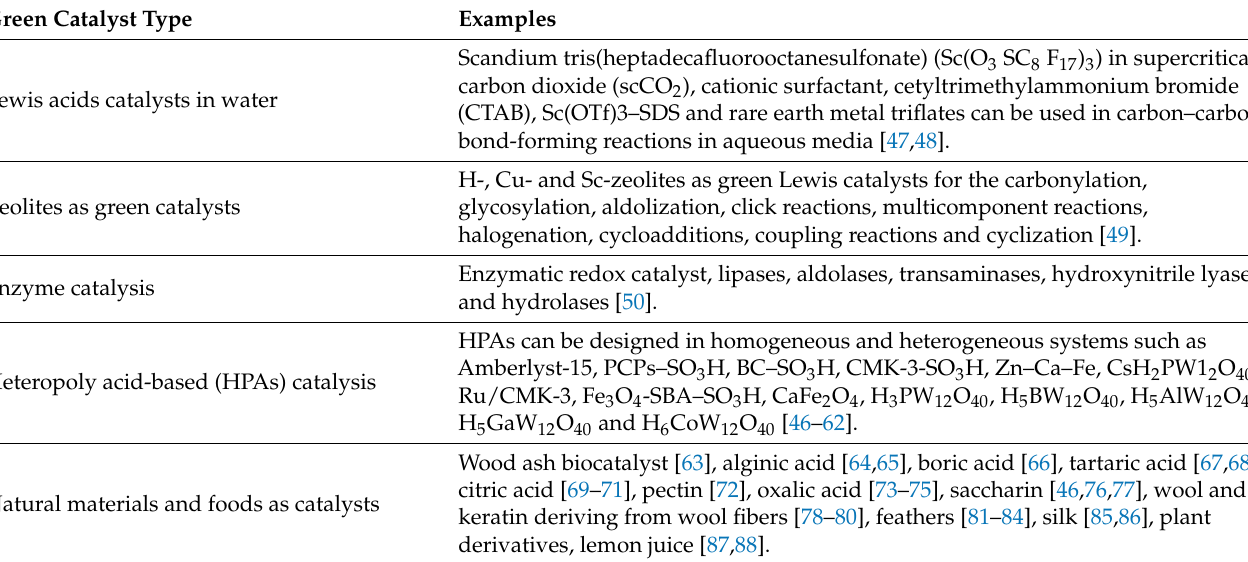
Table 1. Types of catalysts used in green organic synthesis.